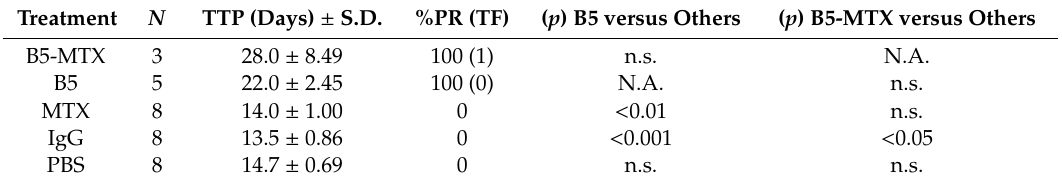
Table 2. Time to tumor progression (TTP) for CLBL1-Luc bearing mice treated with B5 and B5-MTX.